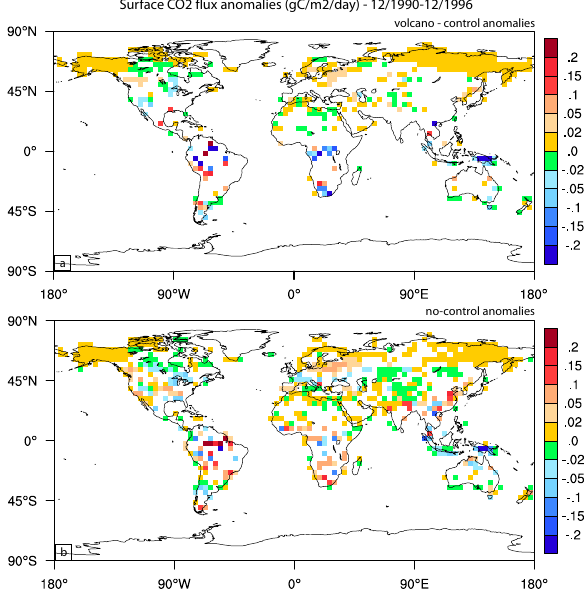
Fig. 6. Surface flux of CO 2 anomalies over land, averaged over the period December 1990–December 1996. Both anomalies using the volcano–control method (a) and the no-control method (b) are plot- ted here where significant at the 90% level. Positive here (warm colors) denotes uptake of carbon by the